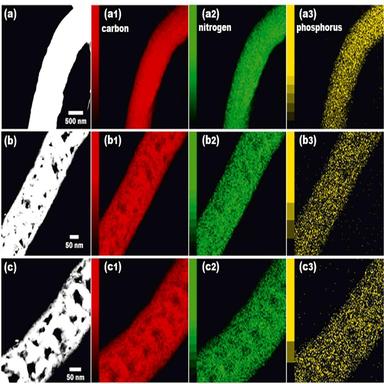
Bright-field TEM images of carbon nanotubes and the corresponding elemental mapping of C (red), N (green), and P (yellow). (For interpretation of the references to color in this figure legend, the reader is referred to the web version of this article.)